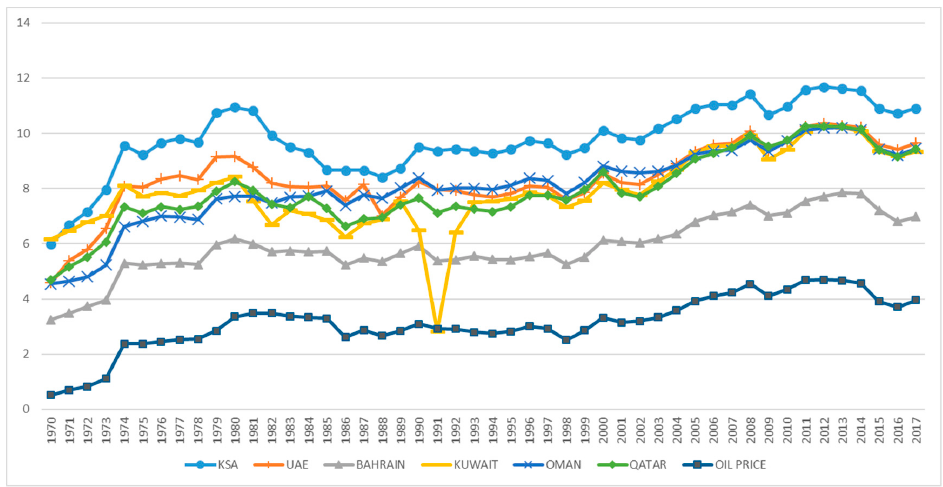
Figure 1. Trend of oil price and energy depletion.